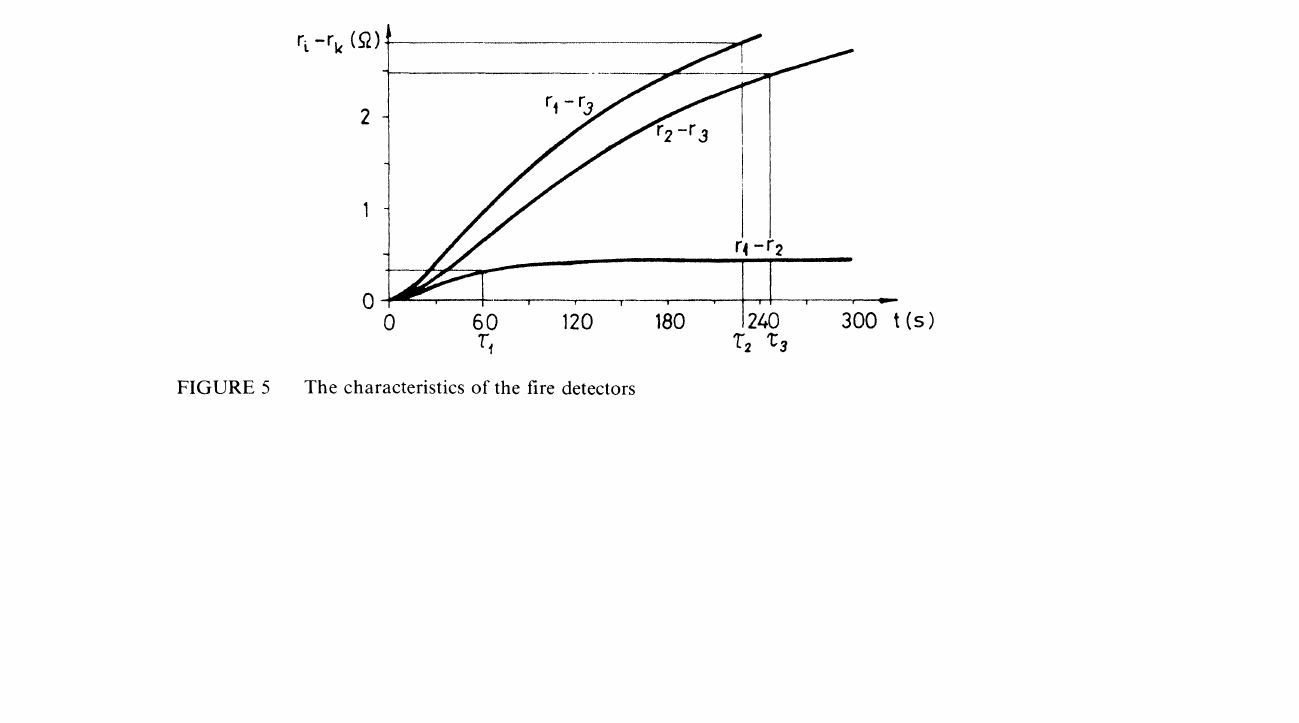
The characteristics of the fire